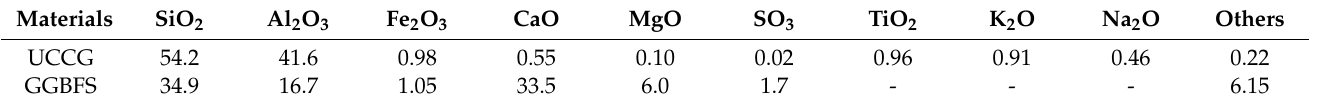
Table 3. Chemical composition of UCCG and GGBFS/%.